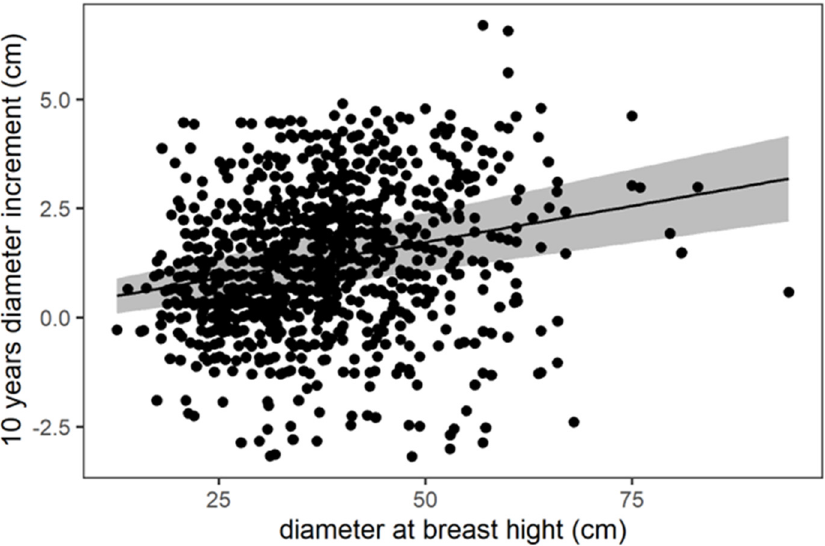
Figure 3. Relationship between the 10-year radial stem increment (10-year diameter increment) and DBH (cm), shown by a linear model. The model explains 5% of the data variability.